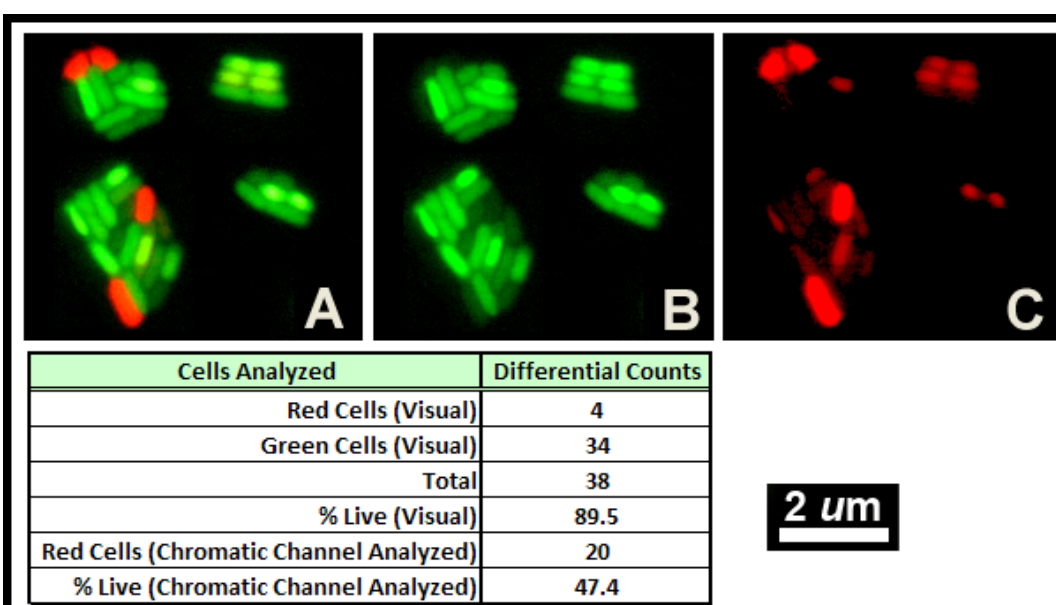
Figure 12. Use of the BacLight  staining method to differentiate ―live‖ versus ―dead‖ cells of Yersinia pestis after prolonged storage in distilled water. (A) Raw RGB image representing the visual result. (B) and (C) show the same microscope field with chromatic separation of each cell’s emitted fluorescence light using color segmentation